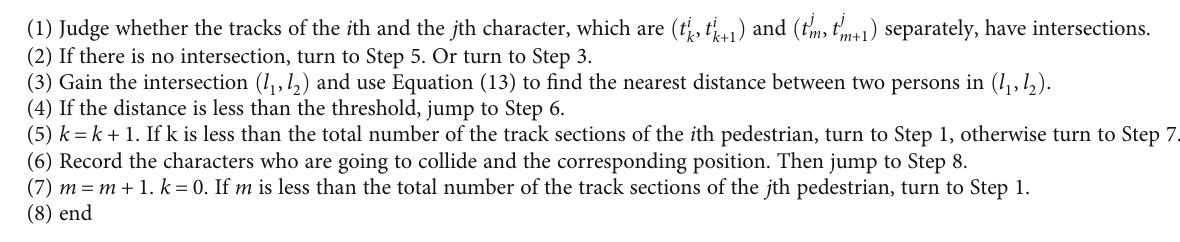
Algorithm 2: Collision